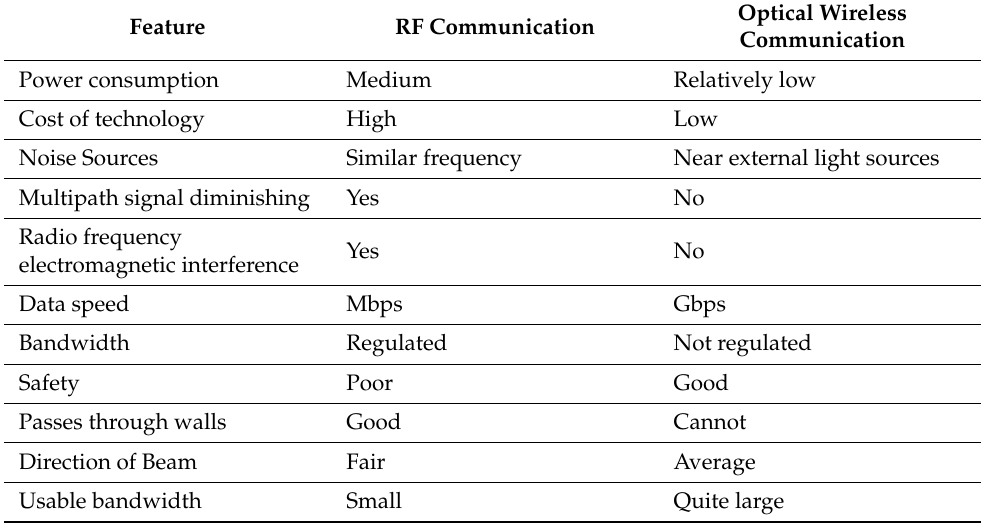
Table 1. Comparison between RF and optical wireless